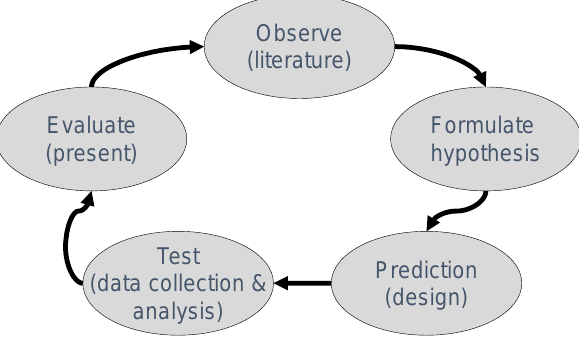
Figure 1. The hypothetico-deductive cycle commonly used in hypothesis testing.